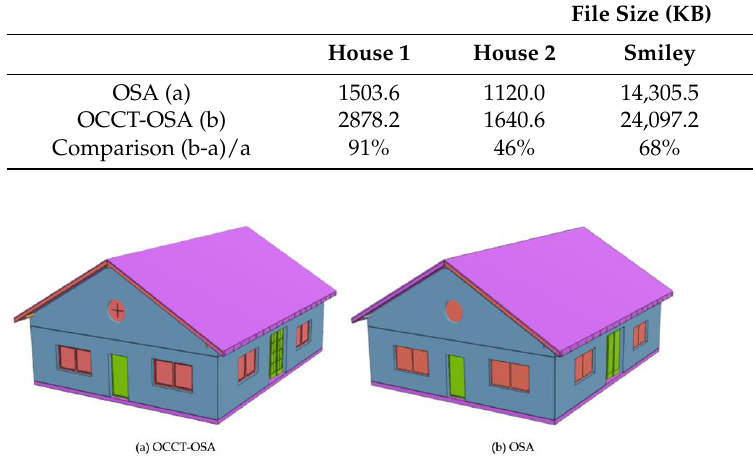
Table 9. File size of models generated by OCCT-OSA and OSA.